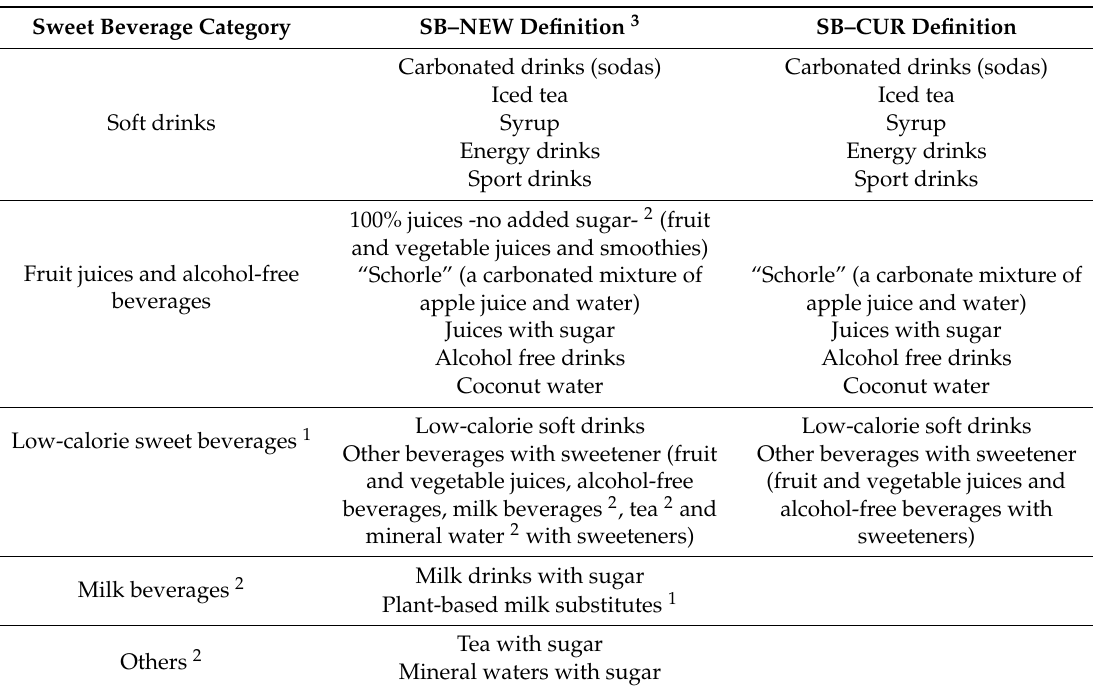
Table 1. Beverages included in SB–NEW and SB–CUR